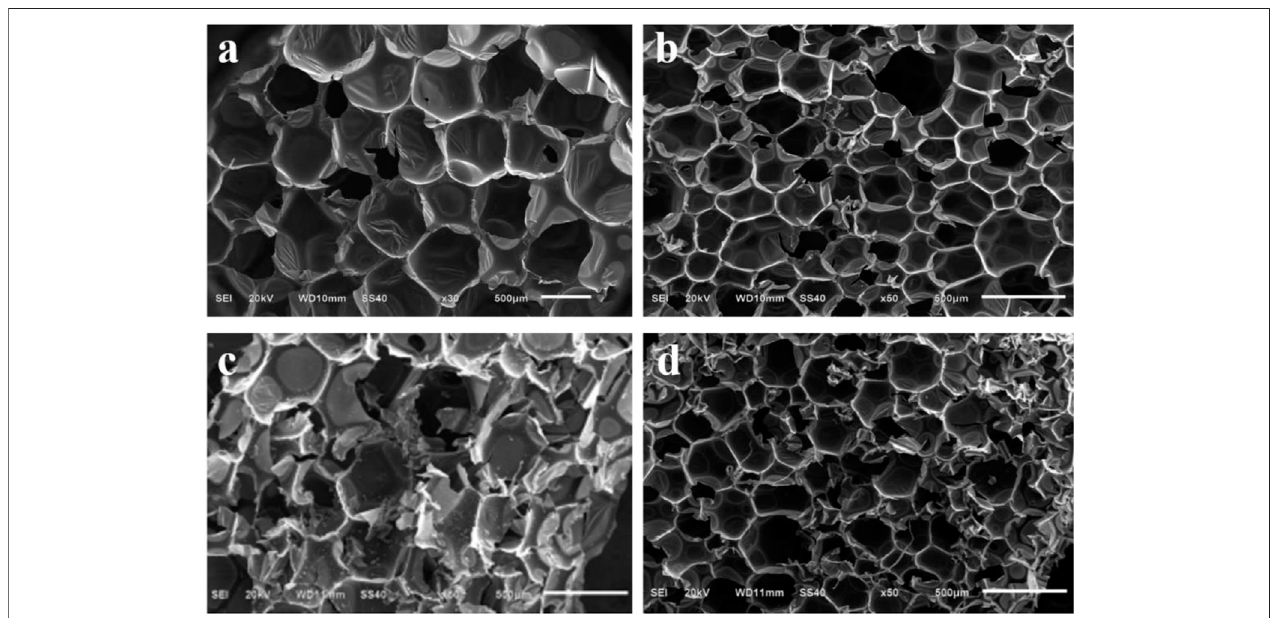
FIGURE 1 | SEM images of RPUF and FR-RPUF composite: (A) RPUF; (B) RPUF/EG30; (C) RPUF/ADP30; (D) RPUF/ADP15/EG15.